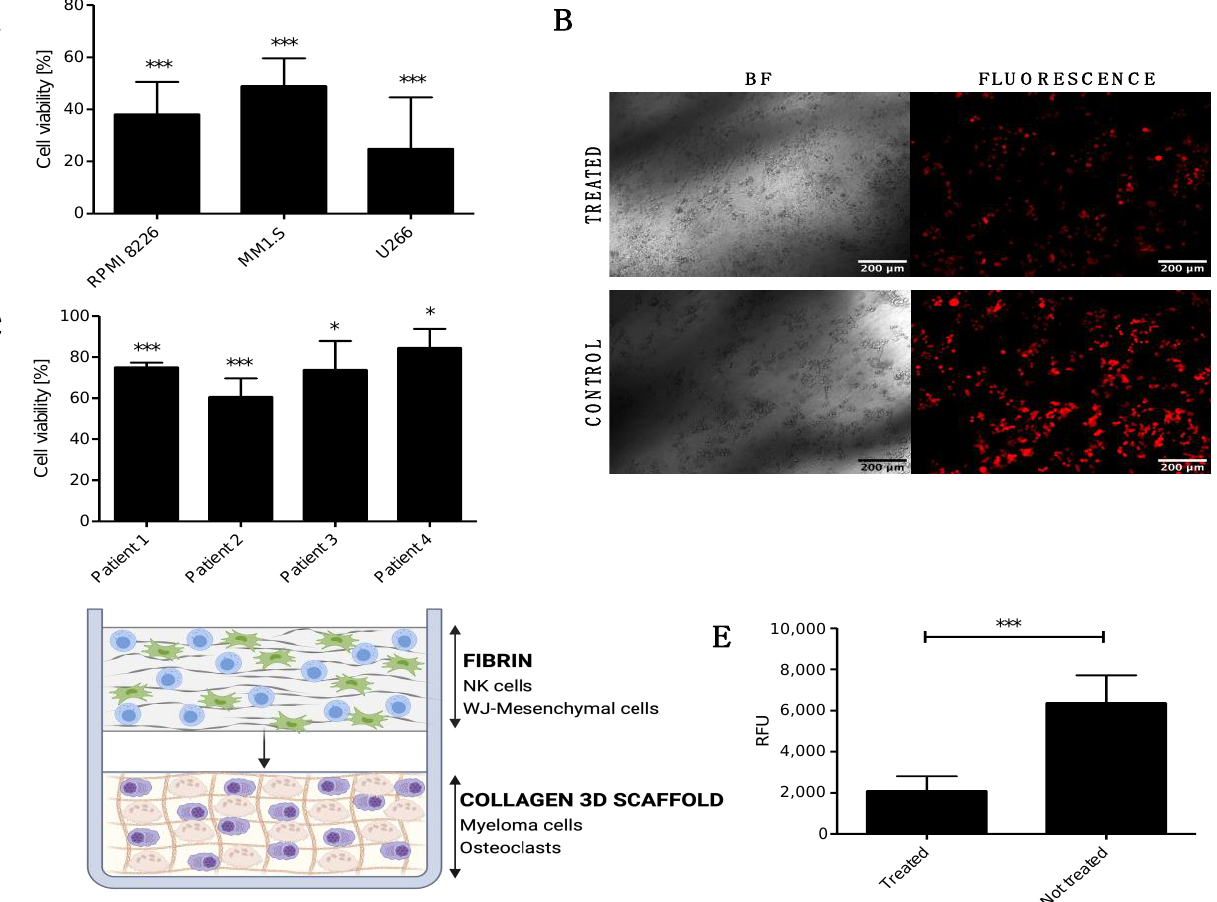
Figure 2. In vitro cytotoxic and anti-osteolytic effect of the FINM prototype in multiple myeloma. ( A ) Viability of RPMI 8226, MM1.S and U266 cells after 7-day co-culture with FINM prototype. ( B ) Fluorescence microscopy image of the RPMI 8226 cells (red), after seven day in co-culture with the FINM prototype (treated) and without (control). ( C ) Viability of primary MM cells from four different patients after 4 h co-culture with the FINM prototype. ( D ) Schematic picture of the prototype application in an in vitro 3D model of MM-induced osteolysis. ( E ) Fluorescence emission (RFU) obtained from supernatant of treated and not treated in vitro model of MM-induced osteolysis, corresponding to cleavage of europium-labelled collagen by OCs. Data in ( A , C , E ) are presented as means ± SD from three technical replicates. ns—not significant; * − p < 0.01; *** − p < 0.001; one-way ANOVA, repeated measures test and Student’s t -test.